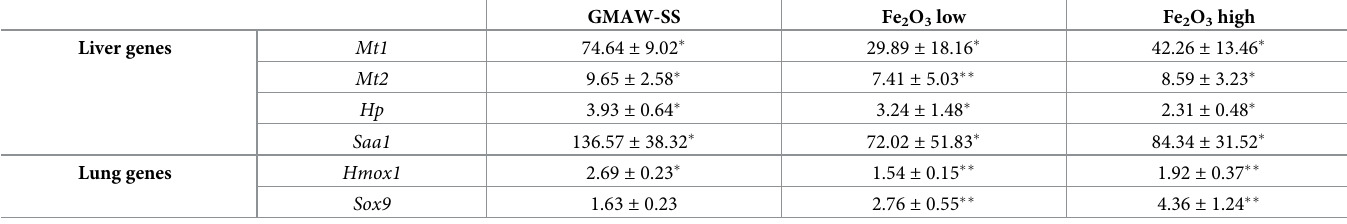
Table 5. Relative mRNA levels as mean fold change ± standard error compared to sham (mean fold change of 1) in the lungs and liver at 1 day post-exposure to GMAW-SS fume or Fe 2 O 3 .